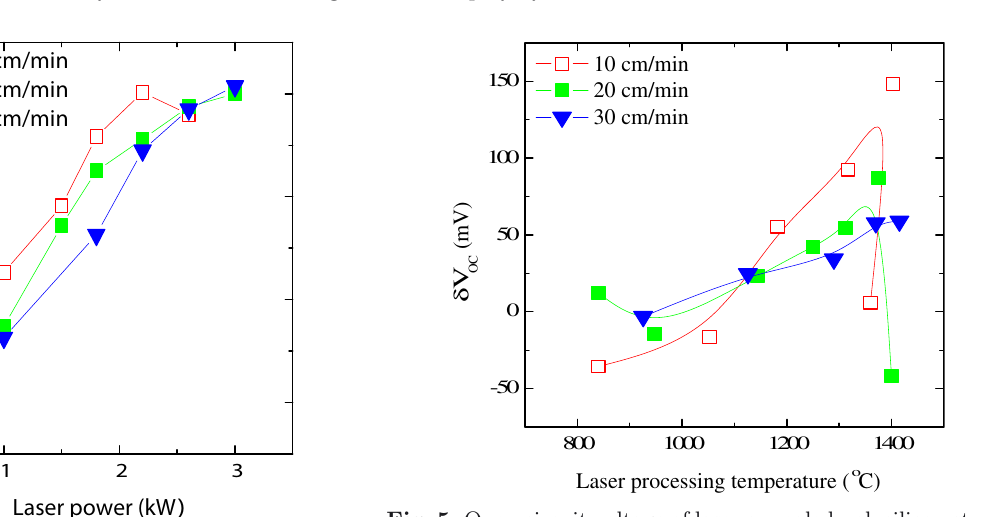
Fig. 4. Variation of processing temperature with respect to variation of laser power at different scan speed.